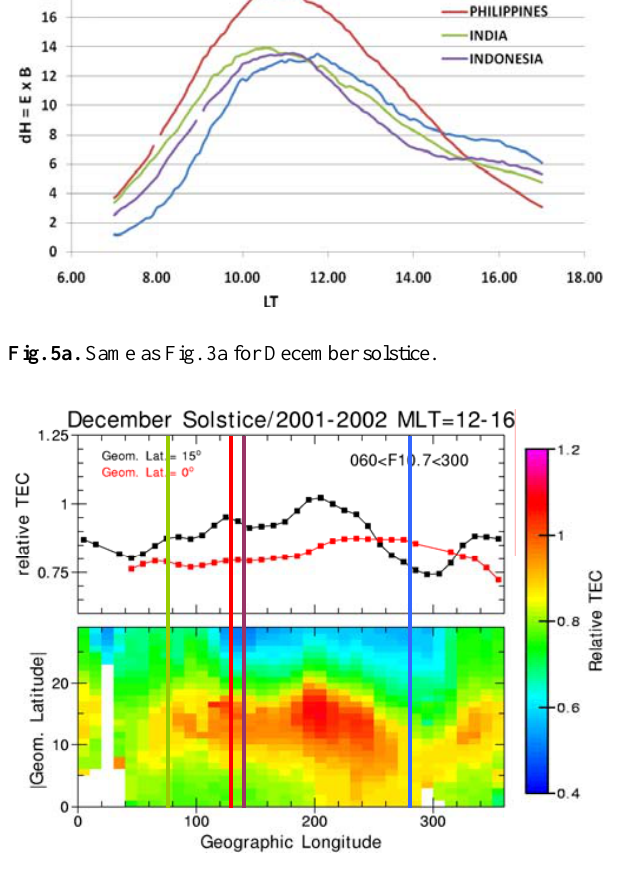
Figure 5a. Same as Figure 3a for December Figure 5b. Same as Figure 3b for Fig. 5b. Same as Fig. 3b for December solstice. solstice. December solstice. of reproducing the sharpness of the boundaries in daytime, vertical E × B drift